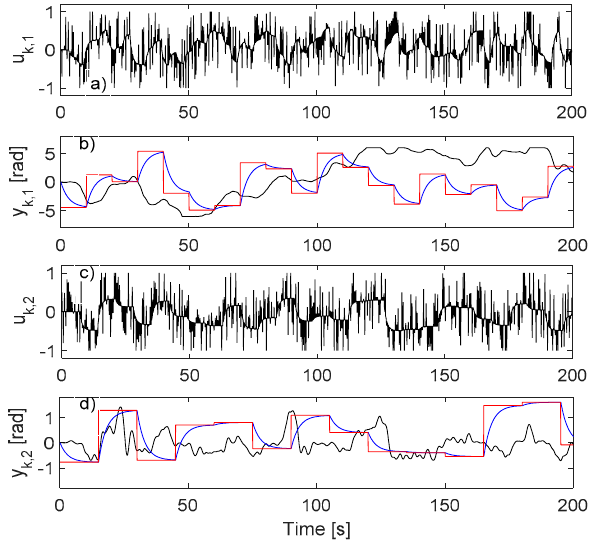
Figure 5. Open-loop input/output (IO) data from the system: ( a ) u k ,1 ; ( b ) y k ,1 (black), y m (red); ( c ) u k ,2 ; ( d ) y k ,2 (black), y m (red)